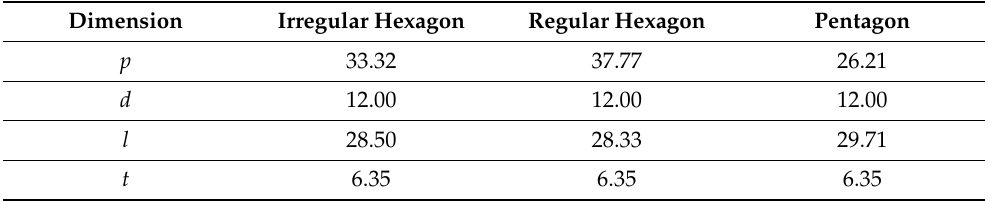
Table 1. Optimized stator pole dimensions